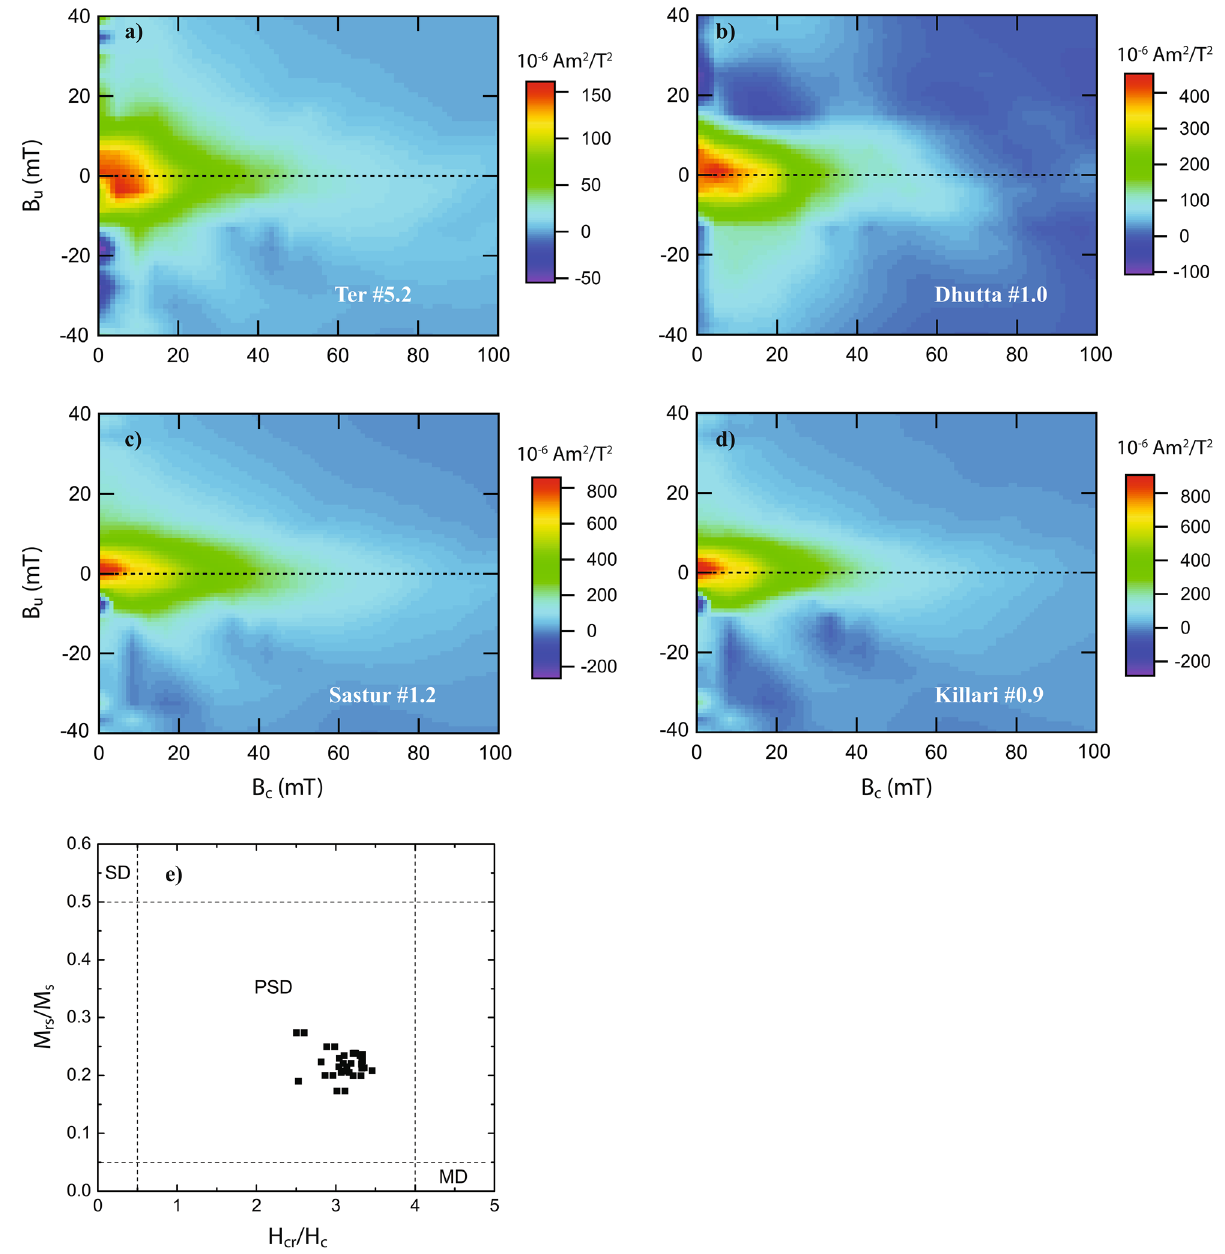
Figure 5. ( a – d ) Representative first-order reversal curve (FORC) diagrams for the representative samples from different depths, (FORCinel) ( e ) Results of Hysteresis measurements presented in a Day plot 64